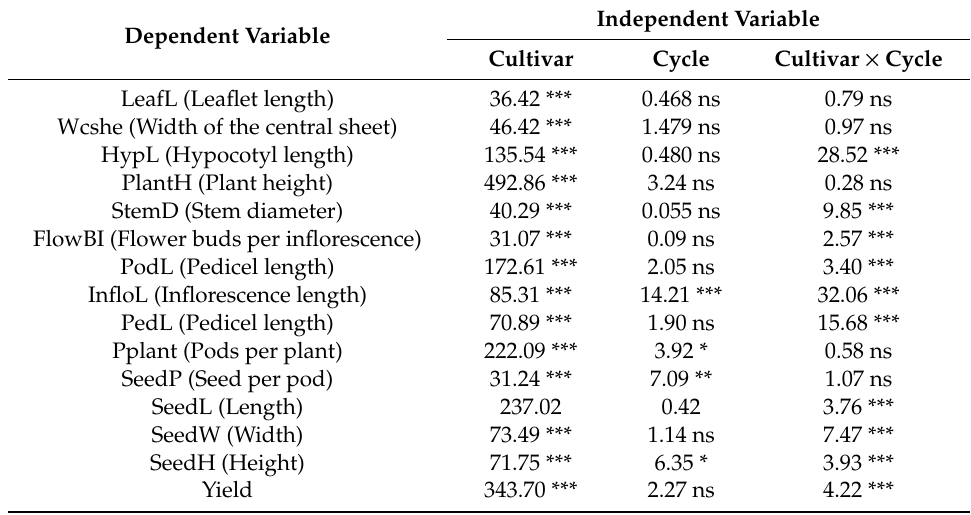
Table 2. Two-way analysis of variance (ANOVA) of cultivar and cycle e ff ects and their interactions for the parameters considered. Numbers represent F-values at the 5% confidence